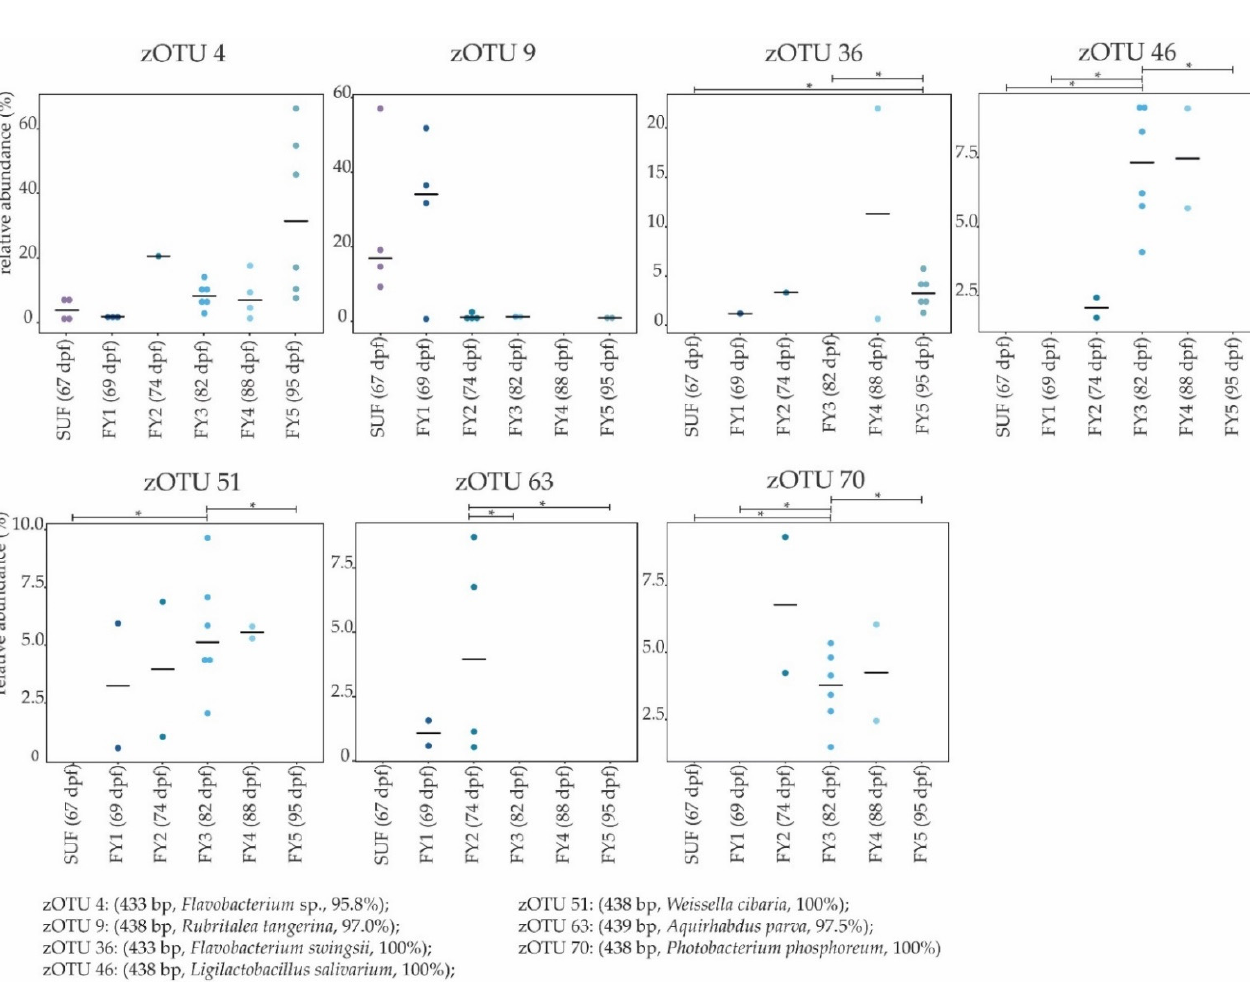
Figure 12. Molecular strains in the fry stages (FY1–FY5) and SUF; Boxplots depict the median (thick bar) and individual samples (points). Brackets above the individual boxplots indicate the significance level for pairwise comparison. zOTUs were identified by EzBiocloud; the sequence length, the closest relative taxon, and the sequence identity score of zOTUs are shown in the order of appearance. SUF, swim-up fry; FY1, fry 69 dpf; FY2, fry 74 dpf; FY3, fry 82 dpf; FY4, fry 88 dpf; FY5, fry 95 dpf; dpf, days post fertilization. P value summary: * p ≤ 0.05